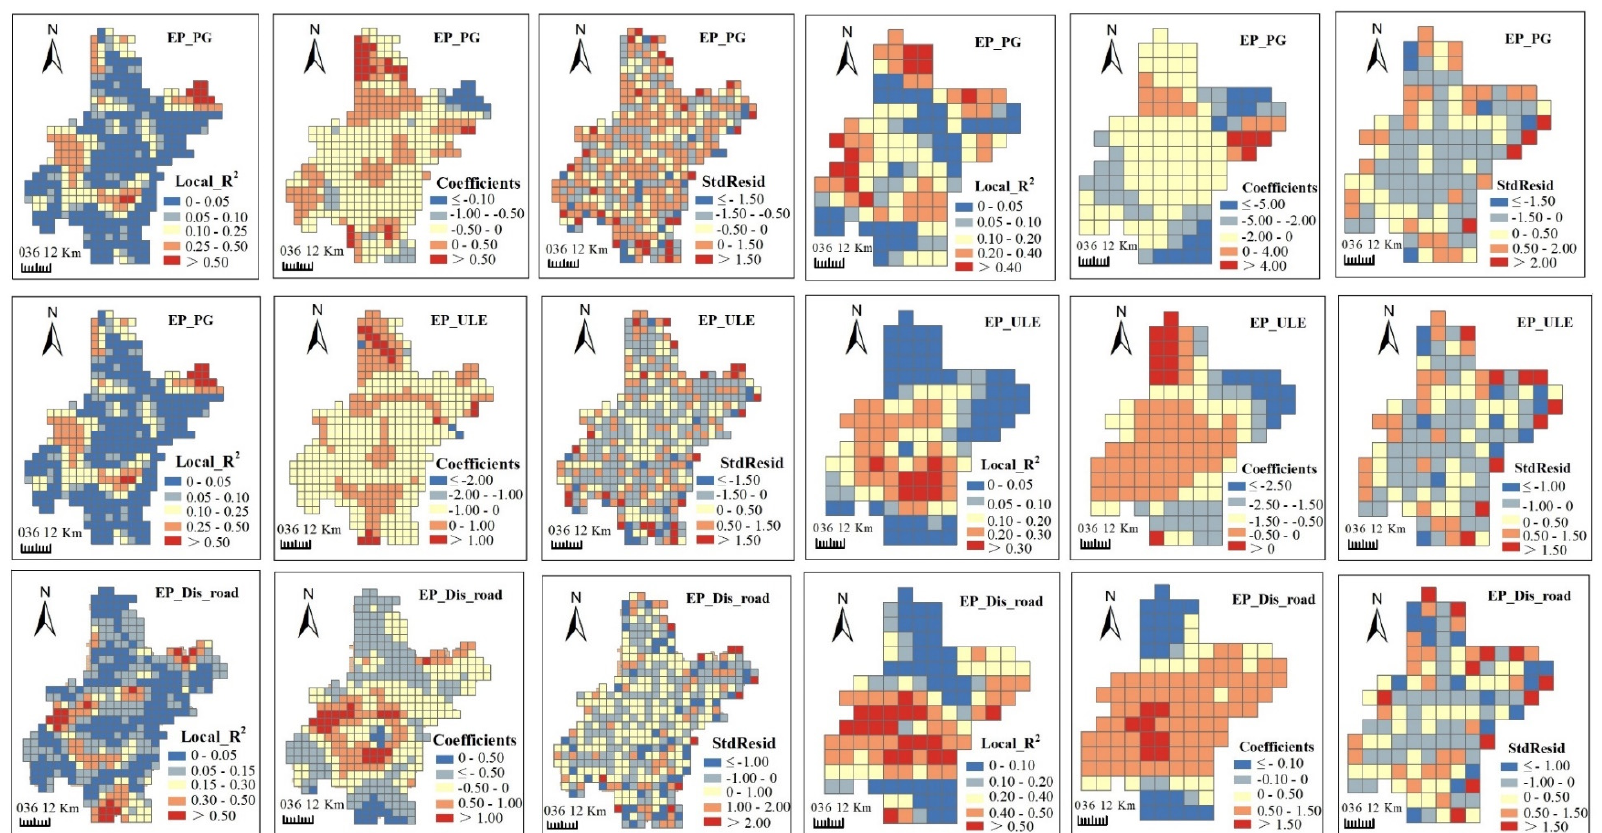
Figure 9. Spatial patterns of local R 2 , coefficients and standard residuals (StdResid) from geographically weighted regressions (GWRs) between erosion prevention (EP) and urbanization indicators at 5 km ( left three columns ) and 10 km ( right three columns ) grid scales. Abbreviations: Population growth (PG); Urban land expansion (ULE); Distance to major roads (Dis_road).